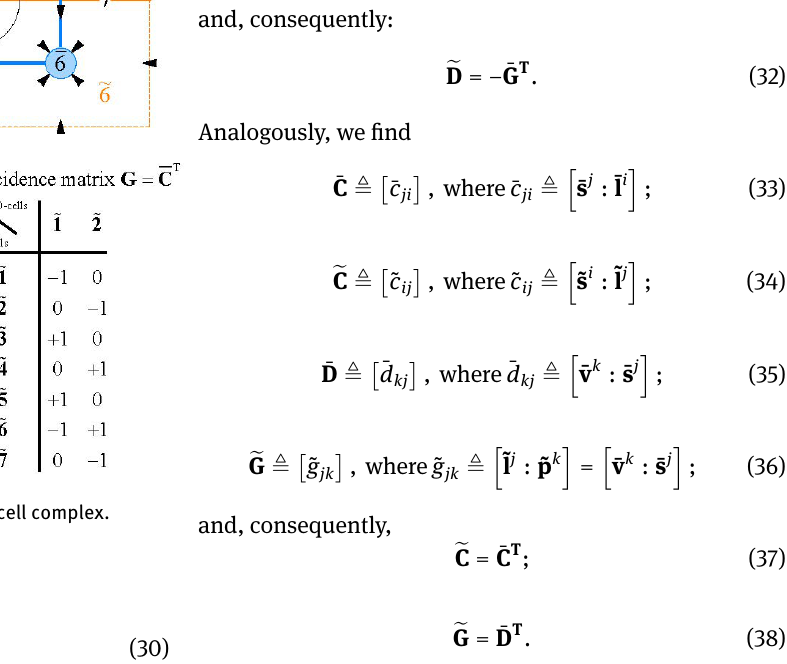
Figure 10: The modified incidence matrices in a plane dual cell com- plex with unit